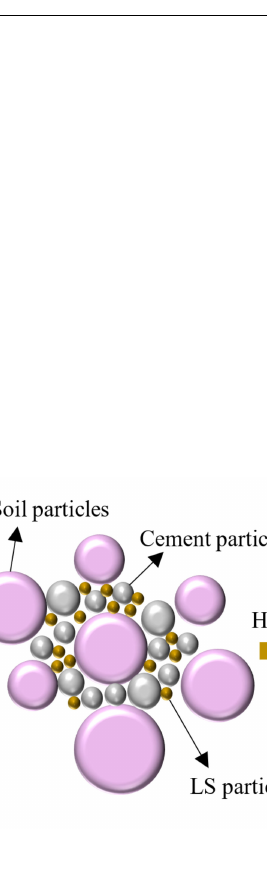
Figure 14. Schematic diagram of the internal action mechanism of LS on